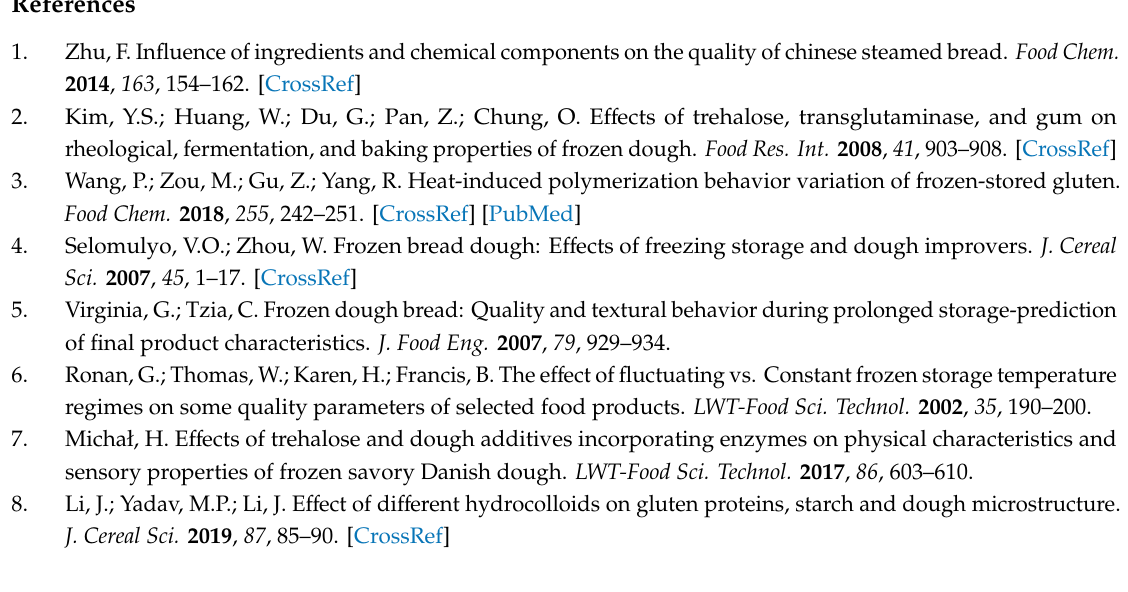
Figure S1: FTIR spectra of gluten samples with di ff erent proportions of KGM added on frozen dough, Figure S2: DSC thermograms of gluten samples with di ff erent proportions of KGM added on frozen dough, Figure S3: Rheological properties of frozen dough with di ff erent KGM added. G (cid:48) (A) and G” (B) for frozen dough without KGM added; G (cid:48) (C) and G” (D) for frozen dough with 0.5% KGM added; G (cid:48) (E) and G” (F) for frozen dough with 1.0% KGM added; G (cid:48) (G) and G” (H) for frozen dough with 1.5% KGM added; G (cid:48) (I) and G” (J) for frozen dough with 2.0% KGM added; G (cid:48) (K) and G” (L) for frozen dough with 2.5% KGM